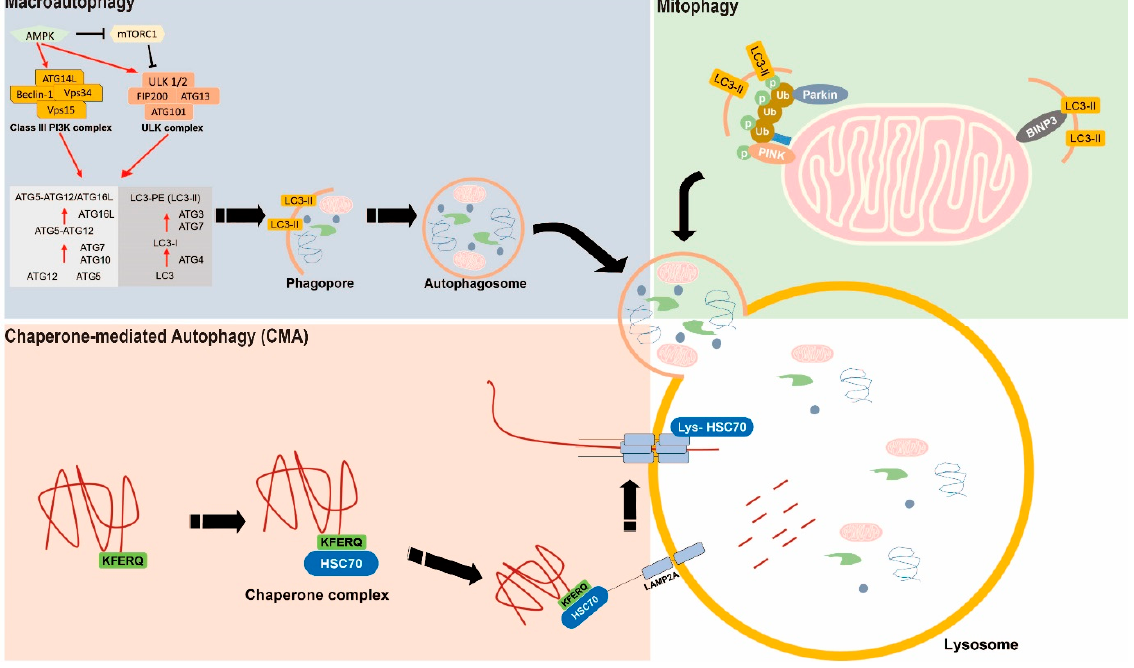
Figure 1. Scheme illustrating the diverse autophagic pathways in cancer cells. Macroautophagy is common autophagic pathway, mitophagy is a specific autophagy, which is working in mitochondria, and chaperone-mediated autophagy is a selective autopahgy with unique mechanism. Black arrows is showed the autophagic pathway. Red arrows is showed the autophagic signal pathway.